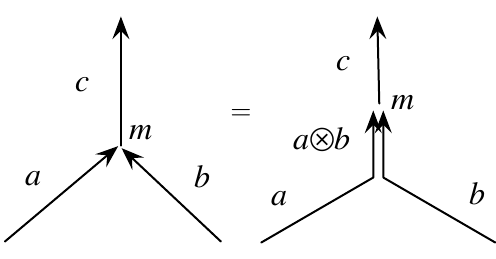
Figure 1 . Two lines with the labels a and b can be fused to form a line with the label a (cid:10) b